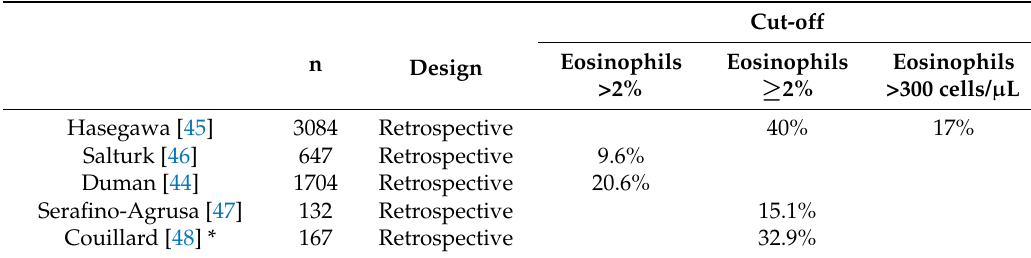
Table 3. Prevalence of eosinophilia in severe COPD